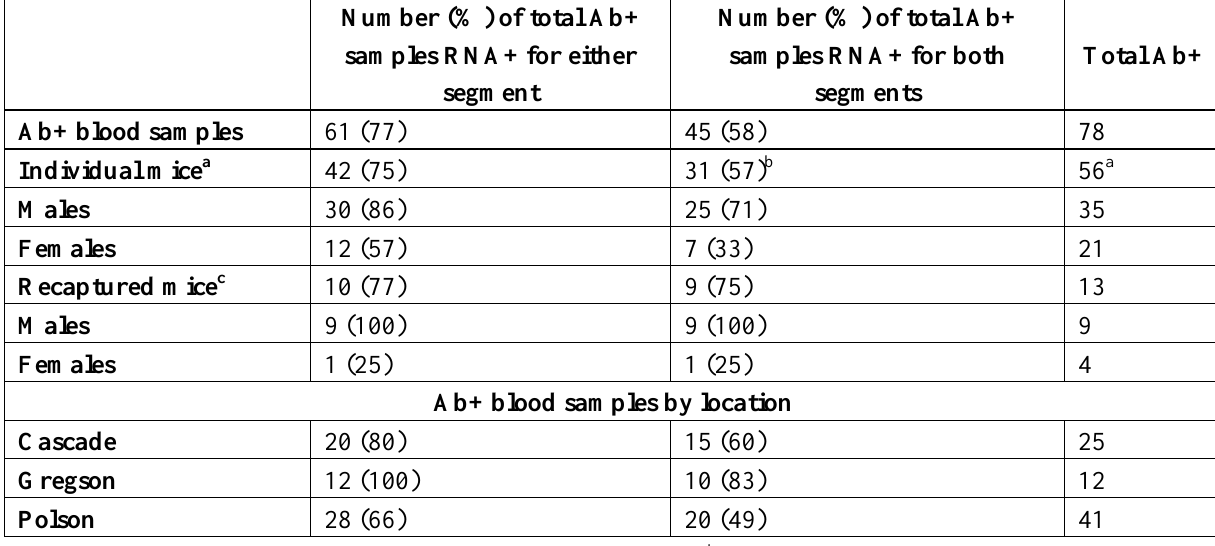
Table 1. Prevalence of detectable viral RNA in Sin Nombre virus antibody-positive blood samples from North American deer mice from southwestern Montana, USA, 2011–2012. Ab+ : antibody positive , RNA+ : positive for viral RNA by RT-PCR